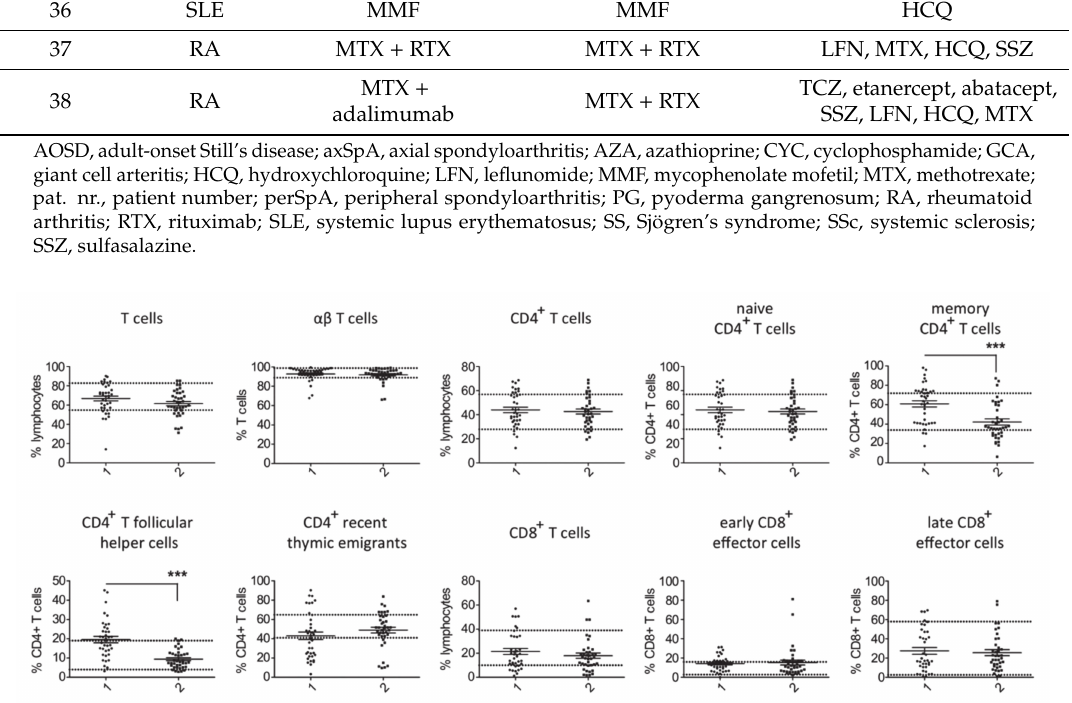
Figure 1. Comparison of T cell subsets in patients with primary (1, n = 38) and secondary (2, n = 38)